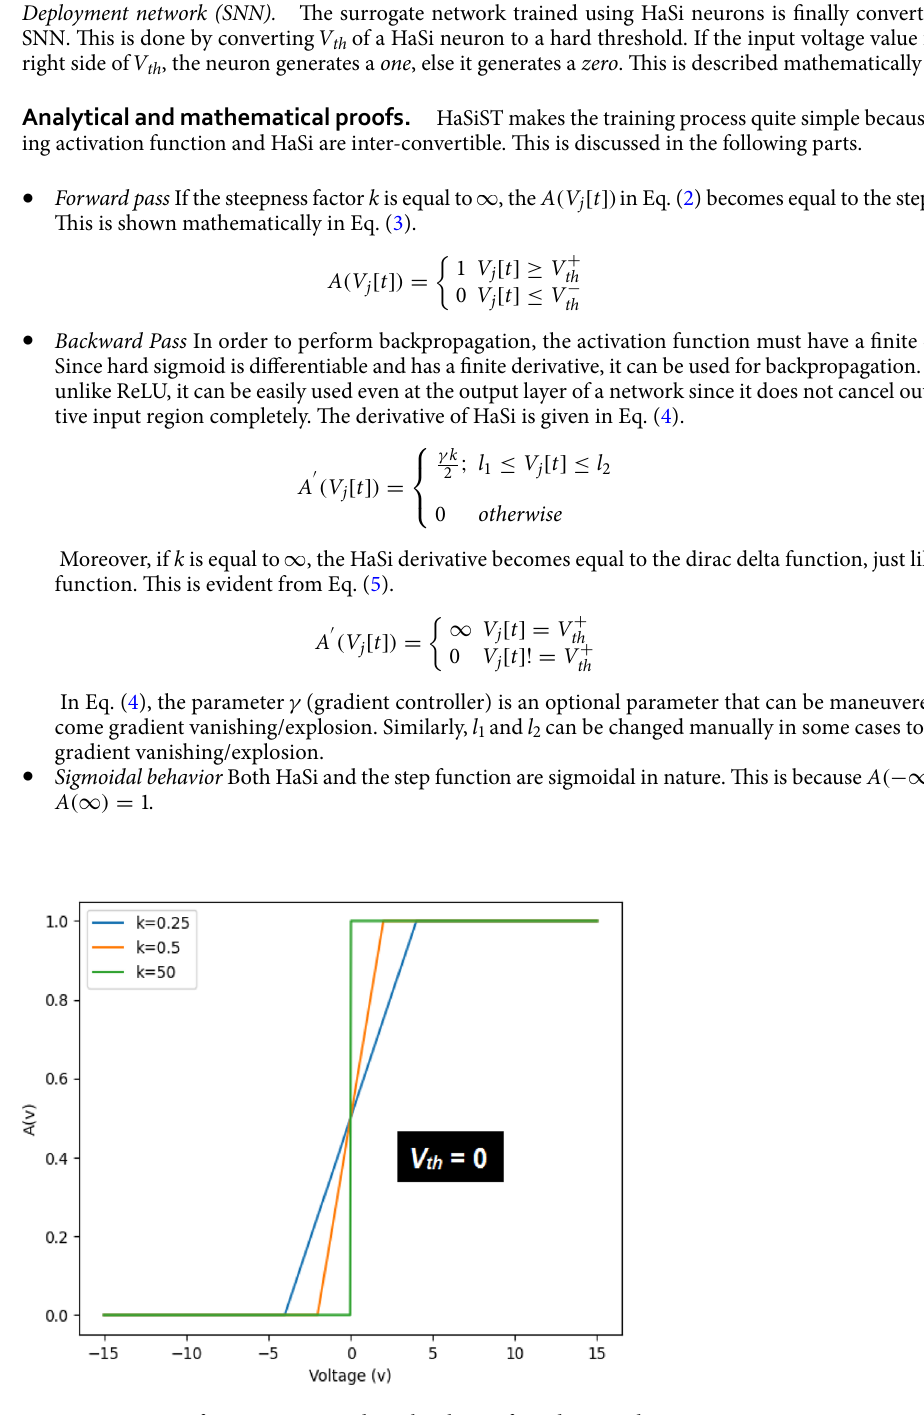
Figure 1. Impact of Steepness Factor k on the Shape of Hard